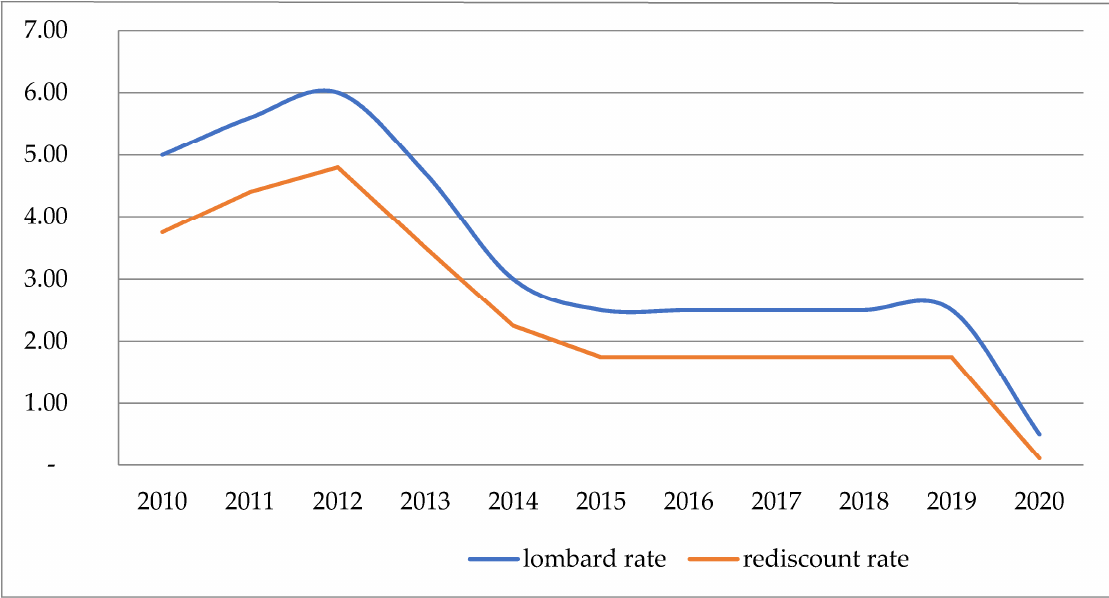
Figure 1. Lombard rate and rediscount level in Poland (2010–2020). Source: own study based on (NBP 2020).